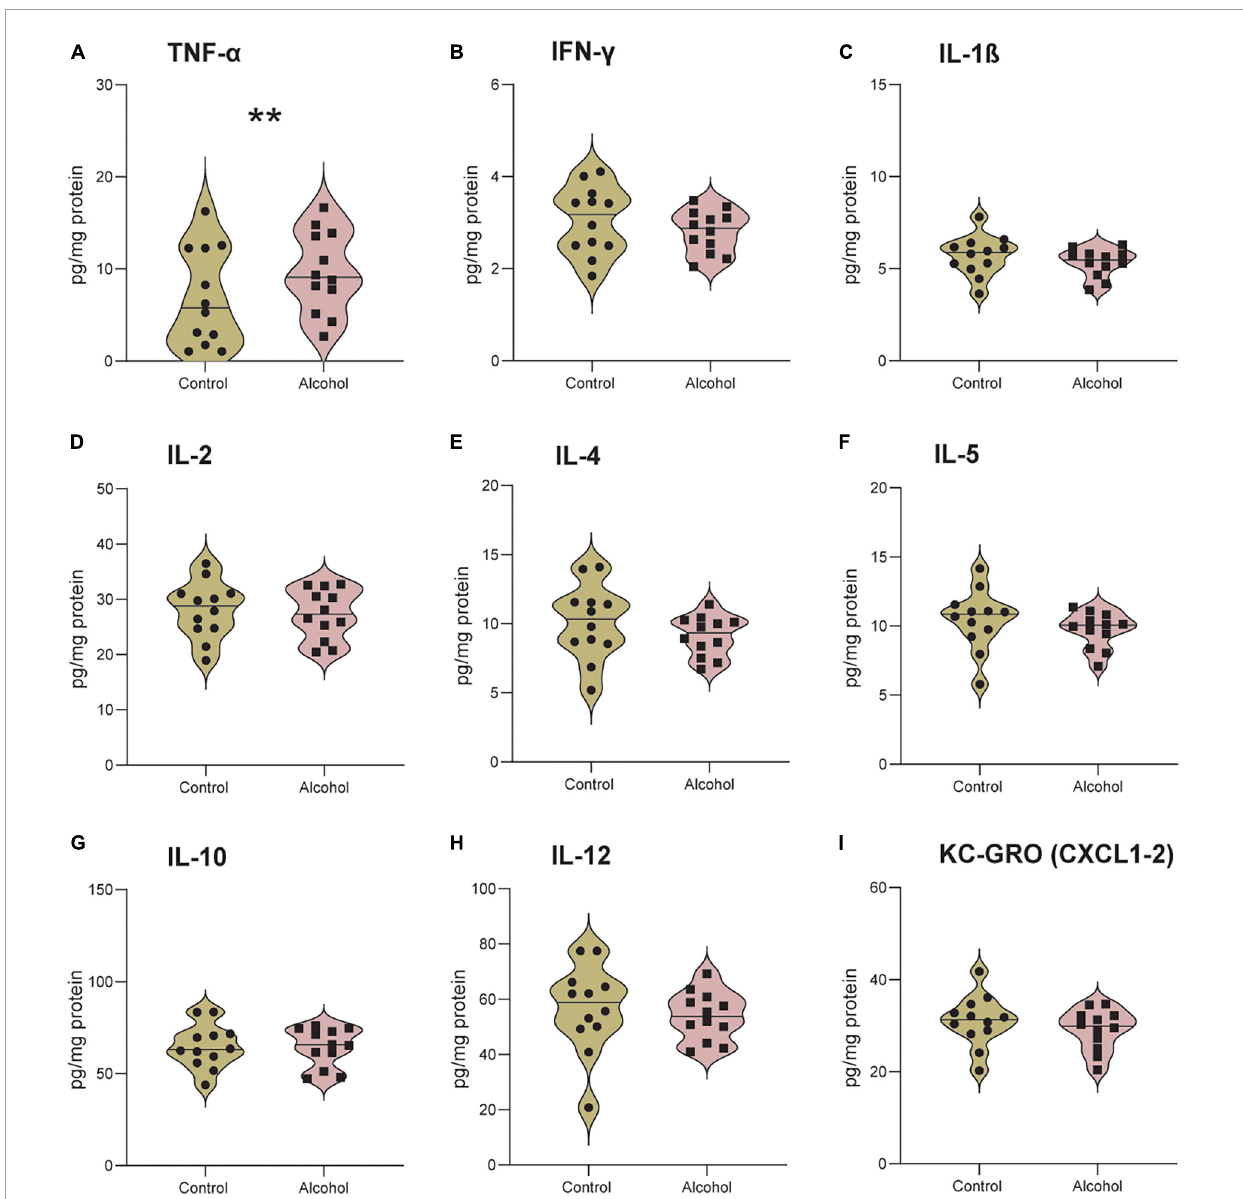
FIGURE8 Increased neuroinflammation following alcohol exposure in B6 mice. The brain levels of TNF- α (A) , IFN- γ (B) , IL-1 β (C) , IL-2 (D) , IL-4 (E) , IL-5 (F) , IL-10 (G) , IL-12 (H) , and KC-GRO (I) in B6 mice. Data are shown as individual subjects with violin plots. n = 12 per group/strain. ** p < 0.01 represents mixed model repeated measures (MMRM) followed by Benjamini–Hochberg’s post hoc , alcohol vs. control.